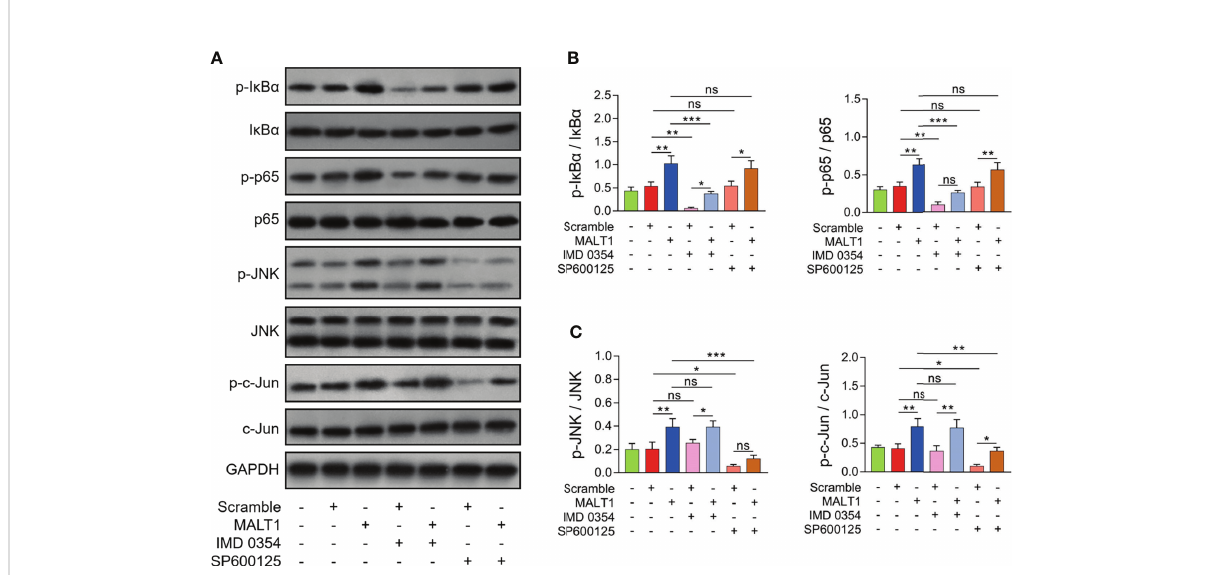
FIGURE 7 Effect of IMD 0354 and SP600125 treatment on NF- k B and JNK pathways in RA CD4 + T cells. Examples of corresponding western blot images after lentivirus transfection, IMD 0354 treatment, SP600125 treatment, alone or in combination (A) . p-I k B a and p-p65 (B) , p-JNK and p-c-Jun